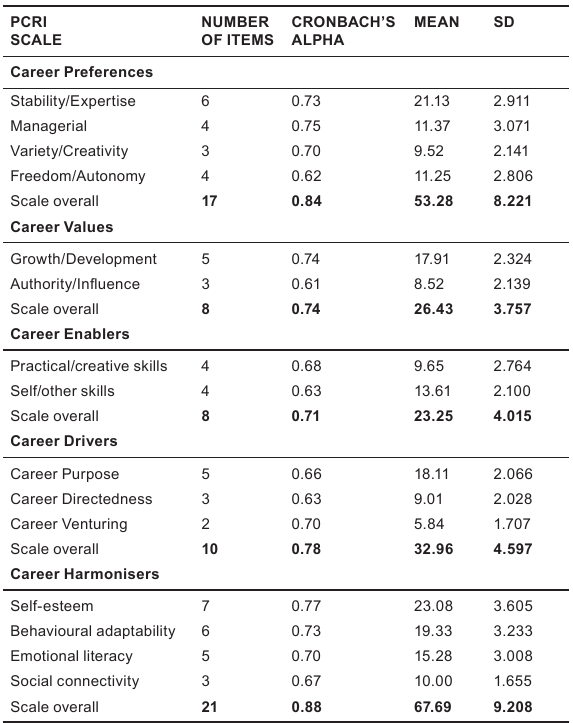
Table 1 Reliability statistics: PCRI scales (N = 2